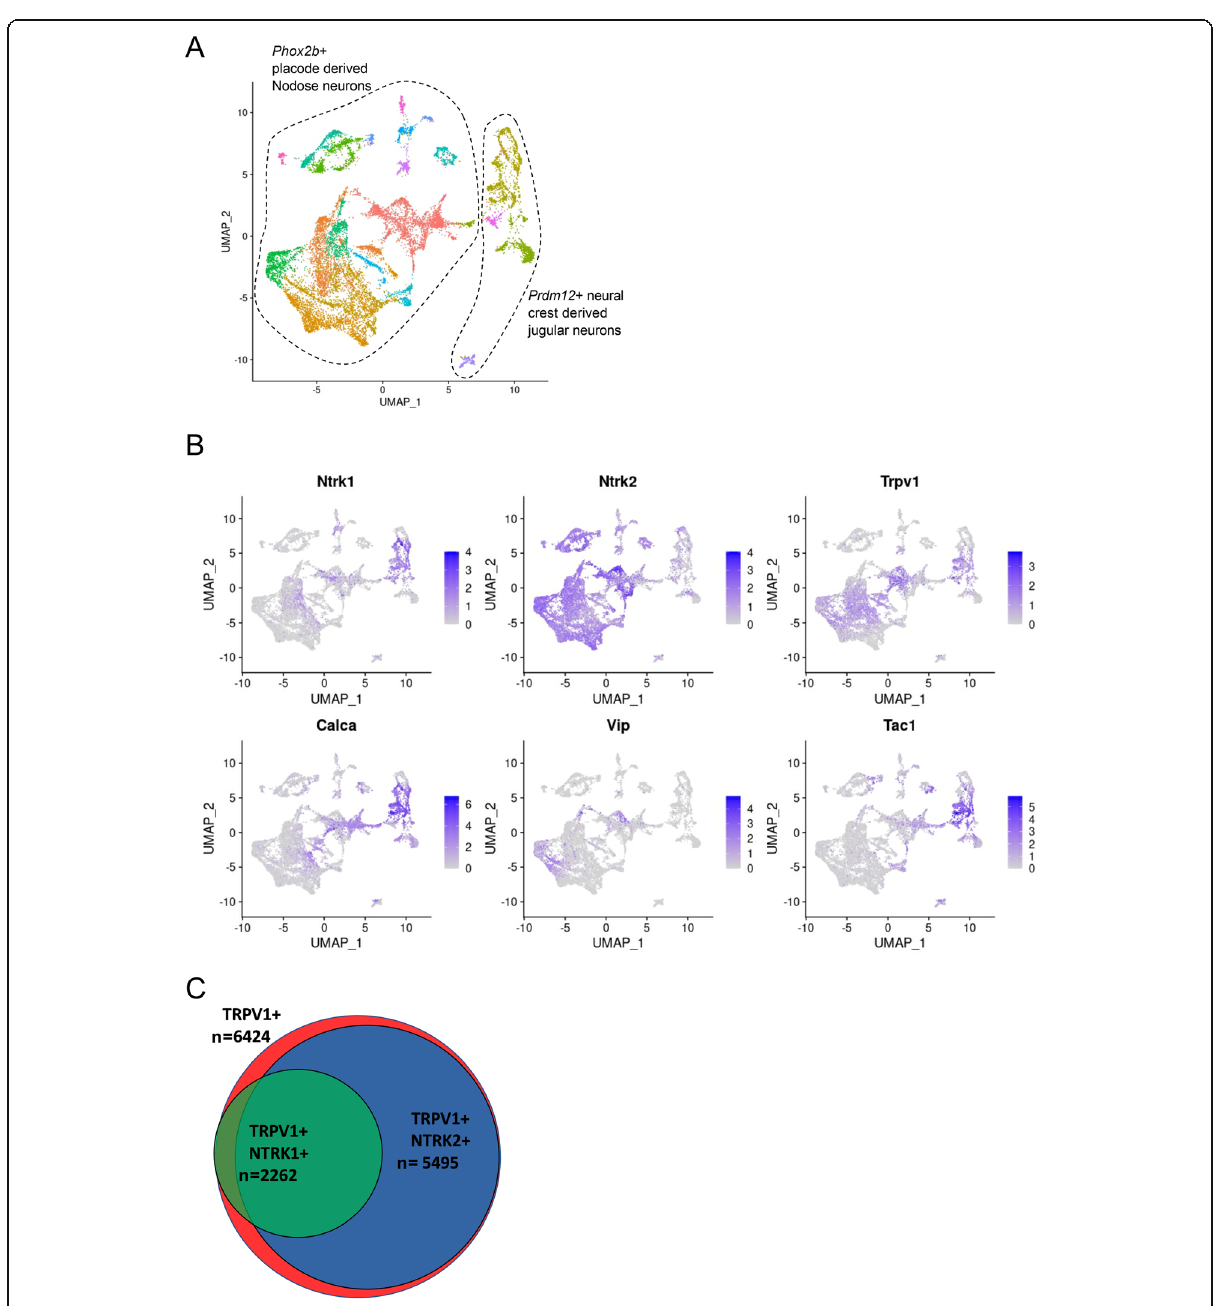
Fig. 5 Nodose neurons have low expression of Ntrk1 but are enriched for Ntrk2 . In-silico analysis of single-cell RNA sequencing of 15,142 Slc17a6 + (Vglut2) JNC sensory neurons ( A ). Phox2b + neurons are derived from the placode which are designated as nodose neurons, while Prdm12 + neurons are derived from the neural crest and indicate jugular neurons ( A ). Uniform Manifold Approximation and Projection (UMAP) were generated, featuring normalized expression of neurotrophins receptors ( Ntrk1, Ntrk2 ), ion channel receptor ( Trpv1 ) and neuropeptides ( Calca, Vip, Tac1 ; B ). Calca, Tac1, Ntrk1 are enriched in jugular (neural crest) neurons whereas Vip and Ntrk2 are preferentially expressed by nodose (placode) neurons (B) . Trpv1 ( n =6424) is expressed in jugular and nodose neurons, Ntkr2 + Trpv1 + neurons ( n =5495) are 2.4-fold more abundant than Ntkr1 + Trpv1 + ( n =2262) neurons ( C ). Experimental details were defined in (Prescott et al.,